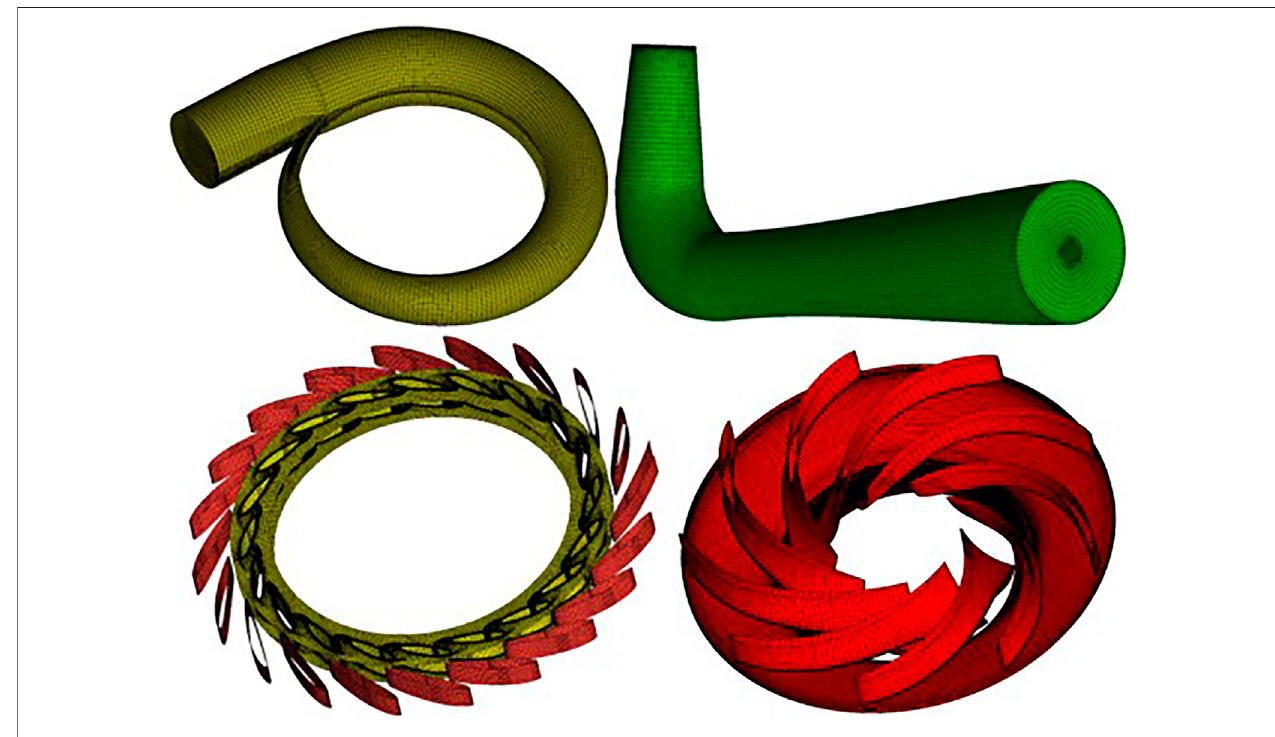
FIGURE 2 | Grids of different parts.